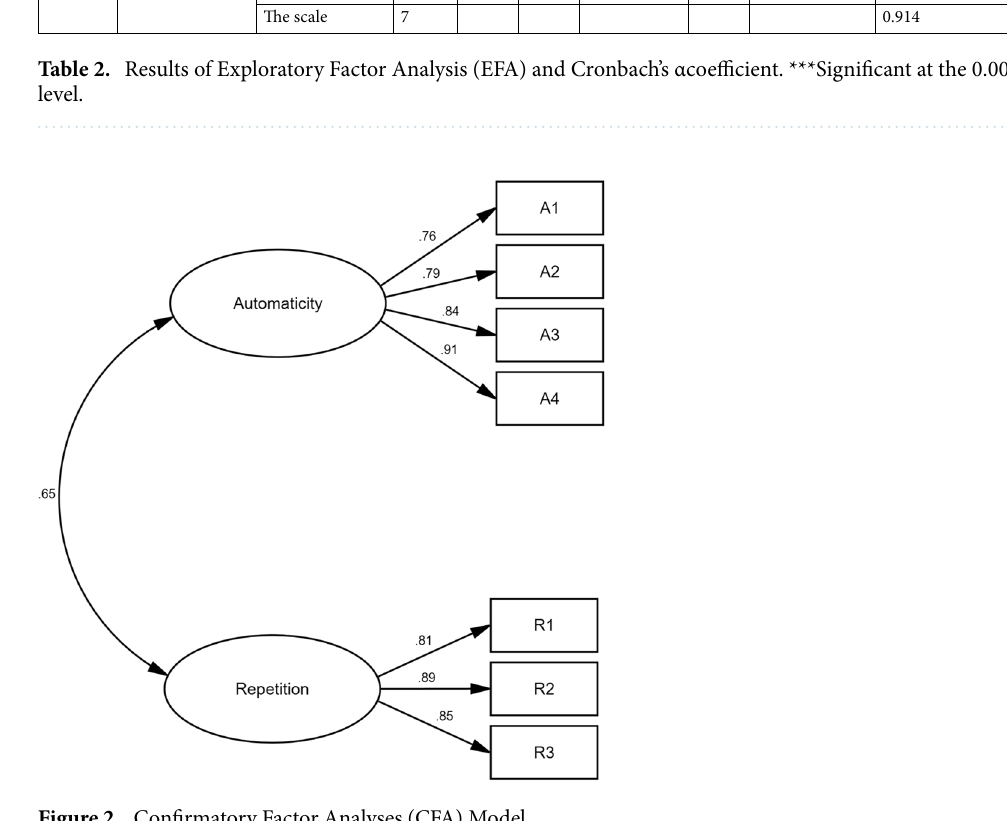
Figure 2. Confirmatory Factor Analyses (CFA)